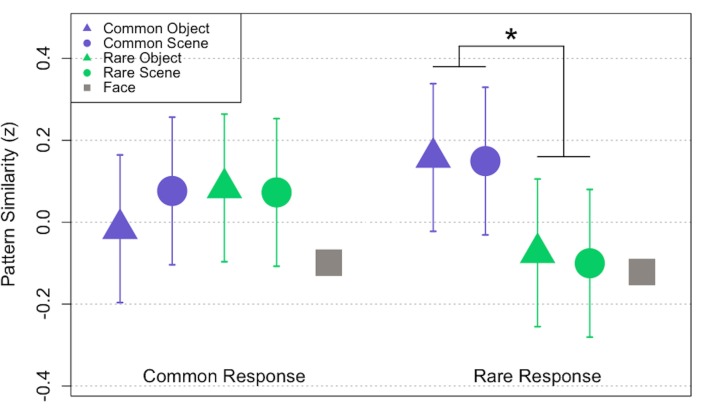
Multivoxel pattern similarity to common and rare objects, scenes, and faces for ambiguous trials in which participants made common (left) and rare (right) responses (mean ± SEM).Purple corresponds to objects/scenes associated with the common category, while green corresponds to the objects/scenes associated with the rare category on a given trial. Triangles indicate objects, and circles indicate scenes. Gray squares depict mean pattern similarity to the non-present face dimension for both response types. *p < 0.05. No error bars are included for the gray bars because face dimensions were not included in the overall mixed effects model.